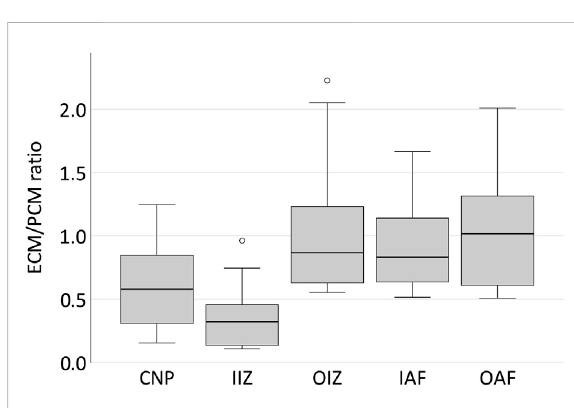
FIGURE 4 The PCM in the bovine IVD is stiffer than the ECM in central areas of the disc while comparable in size in the outer parts. Boxplots showing the ECM/PCM ratio of the Young ’ s modulus for the different locations in fi ve different bovine discs from the centre to the periphery. It can be noted that while in the outer areas of the disc ECM and PCM are of a comparable order of magnitude, the PCM is much stiffer than the ECM in the centre of the disc with a ratio of 0.58 for the central nucleus pulposus and even 0.32 for the inner intermediate zone. Abbreviations: CNP - central nucleus pulposus; IIZ - inner intermediate zone; OIZ - outer intermediate zone; IAF - inner anulus fi brosus; OAF - outer anulus fi